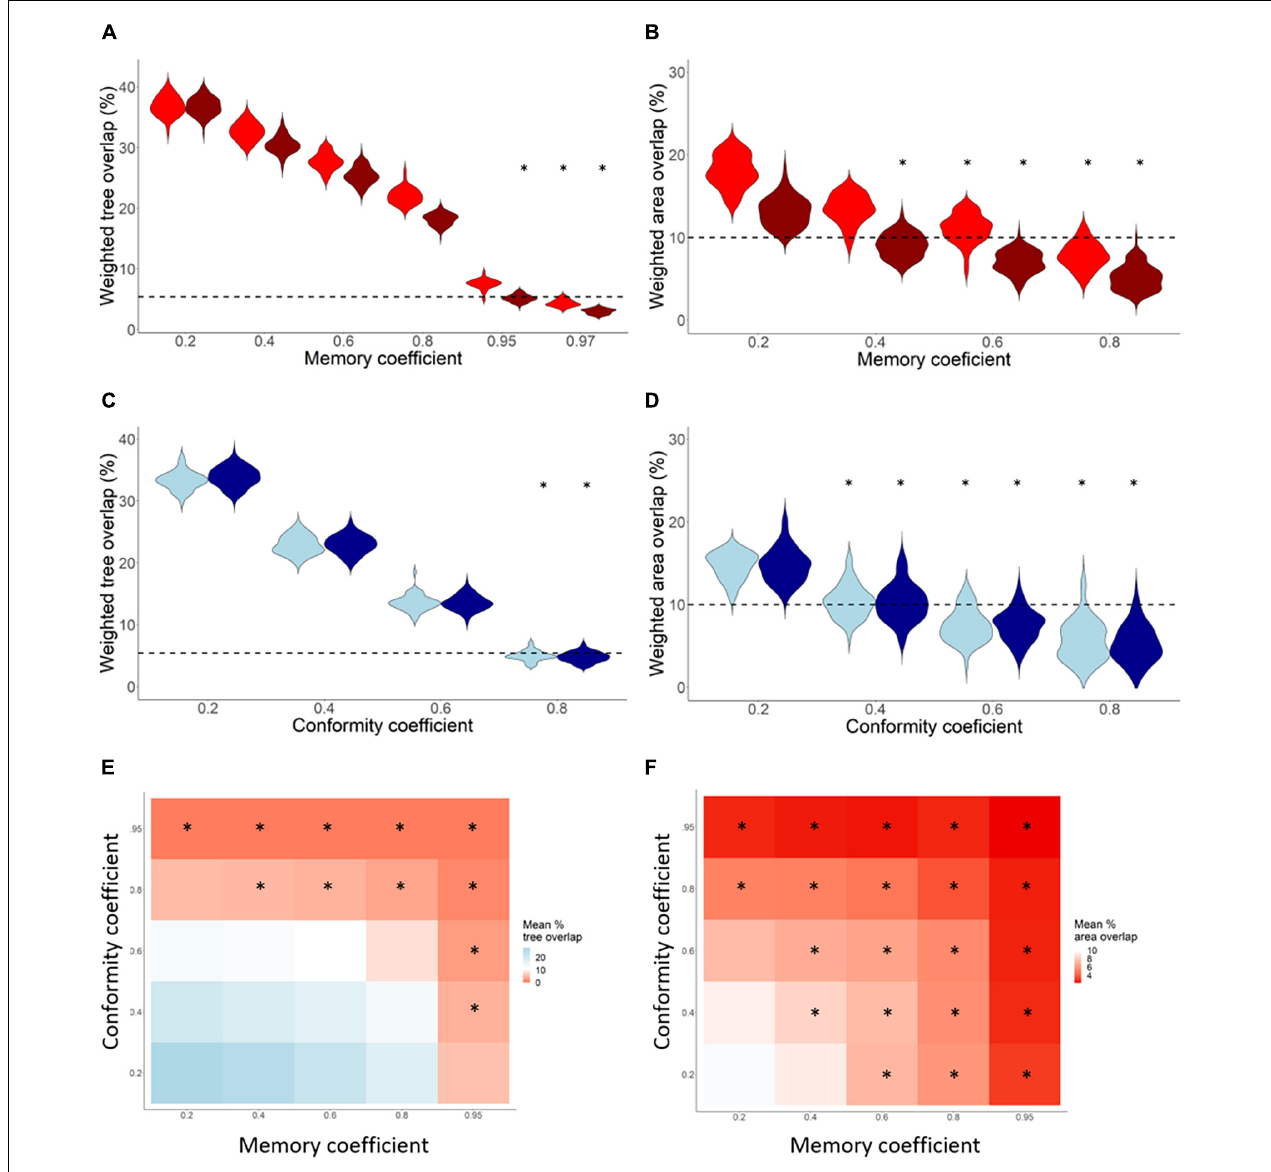
FIGURE 4 | Resource and spatial partitioning between two neighboring Egyptian fruit bat colonies. Each violin plot (A–D) represents the frequency distribution of the weighted tree overlap (WTO, A,C ) and weighted area (75% KUDs) overlap (WAO, B,D ) after 100 iterations of the agent-based models. (A–B) represent increasing values of theoretical memory coefficients on the x-axis in red (range 3–42% for WTO and 2–23% for WAO), and memory with competition in dark red (range 3–42% for WTO and 2–23% for WAO). (C,D) Represent increasing values of theoretical conformity coefficients on the x-axis in blue (range 3–39% for WTO and 0–19% for WAO), and conformity with competition in dark blue (range 3–40% for WTO and 0–23% for WAO). All dashed lines represent the observed WTO or WAO. Heatmaps (E,F) show the combined effect conformity and memory coefficients on the WTO (E) and WAO (F) indices, with darker red colors indicating smaller overlap. ∗ p -value ≥ 0.05 comparing simulated and